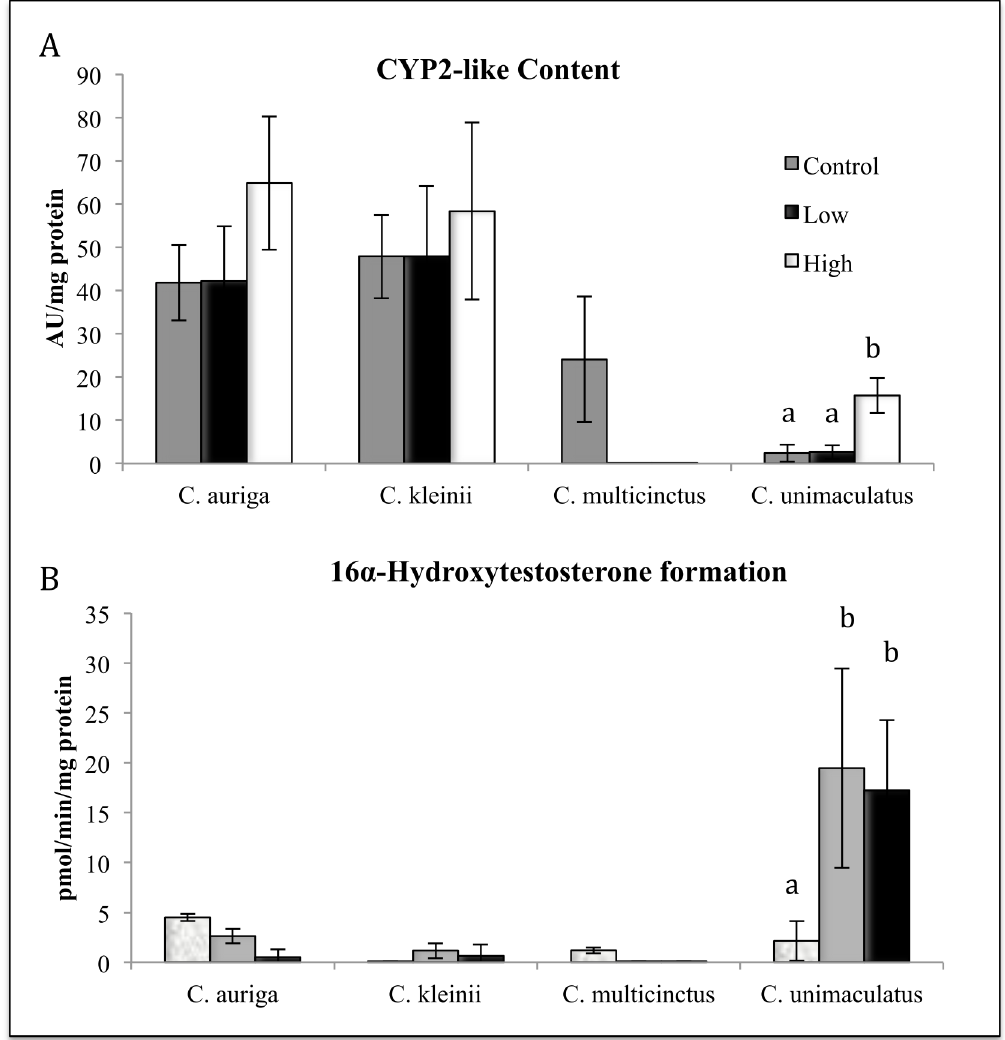
between untreated and treated fish (N = 6 –